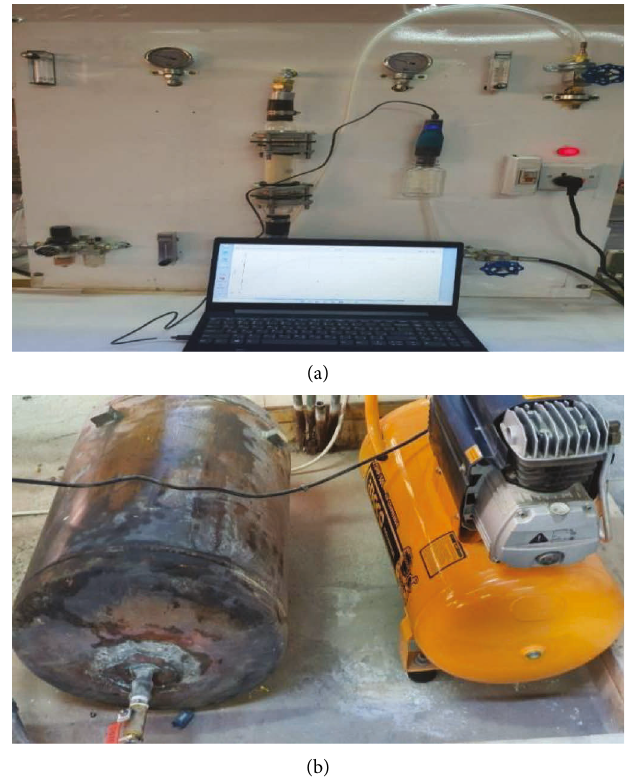
Figure 1: Photograph of experimental layout. (a): experimental setup. (b): compressor and